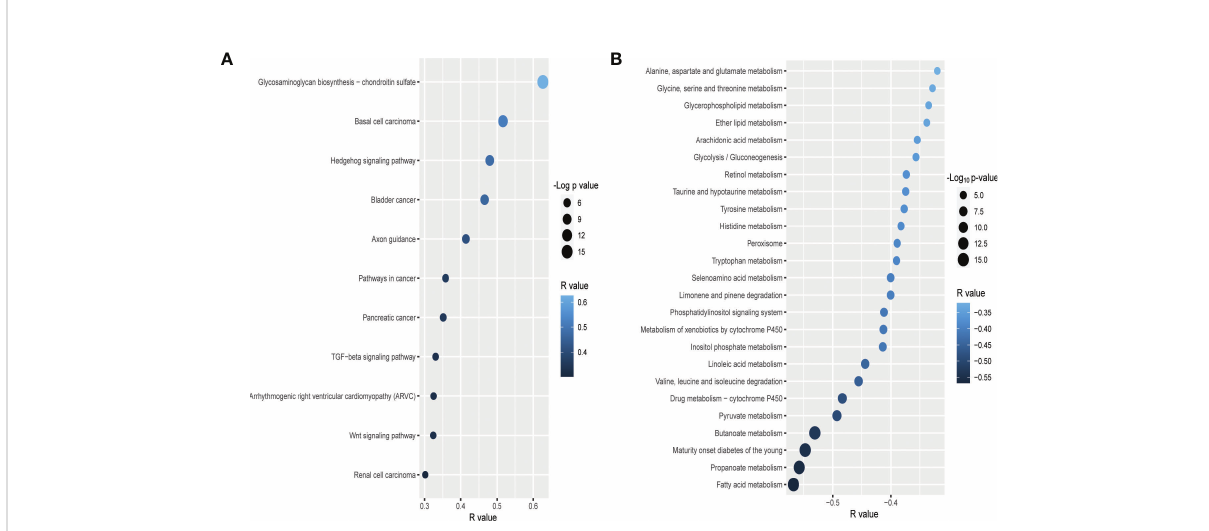
FIGURE 5 Correlation of PLAU upregulation with cancer-associated and metabolic pathways in PDAC. In the TCGA PDAC cohort, upregulation of PLAU gene expression is (A) directly and positively correlated with cancer-associated pathways and (B) negatively correlated with metabolic pathways